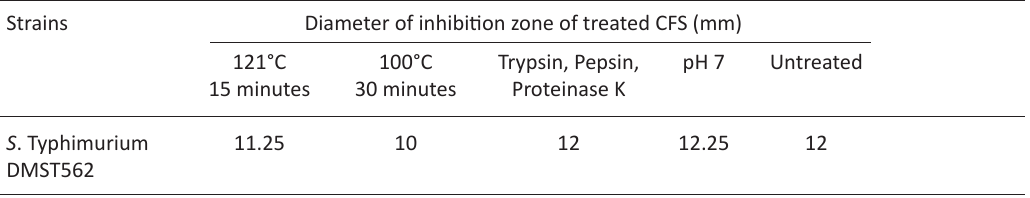
Table 5. Diameter of the PS34 CFS-induced S . Typhimurium DMST562 inhibition zones after heat treatment, proteolytic enzyme treatment, or pH neutralization Strains Diameter of inhibition zone of treated CFS (mm) 121°C 100°C Trypsin, Pepsin, pH 7 Untreated 15 minutes 30 minutes Proteinase K S . Typhimurium 11.25 10 12.25 12